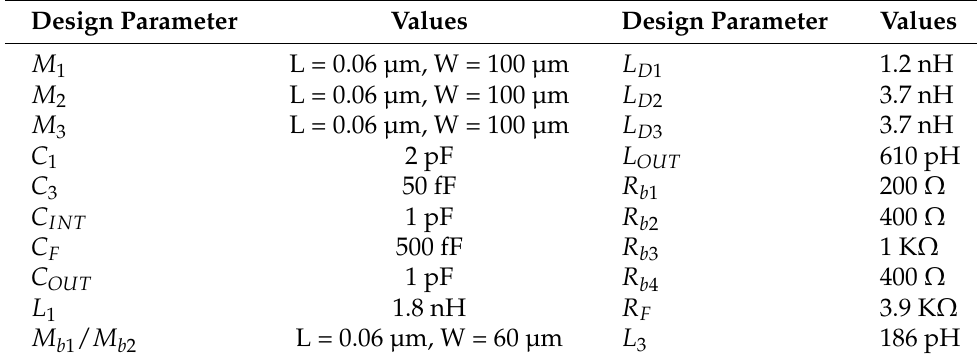
Figure 4. Simulated S21 with and without feedback resistor. Table 1. Design parameter values of proposed